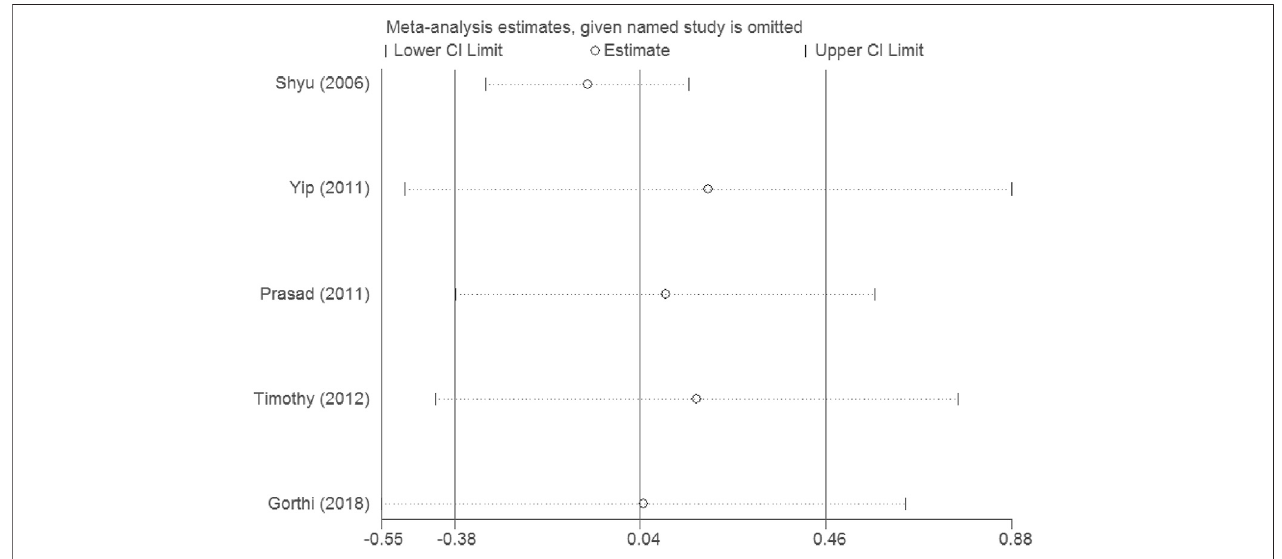
FIGURE 11 | Sensitivity analysis for BI. CI, con fi dence interval.